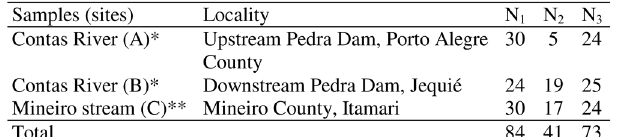
Table 1. Localities and sample sizes of Astyanax aff . bimacu- latus for morphologic (N (N ) analyses (*Contas River Basin, ** Recôncavo Sul Basin). 3